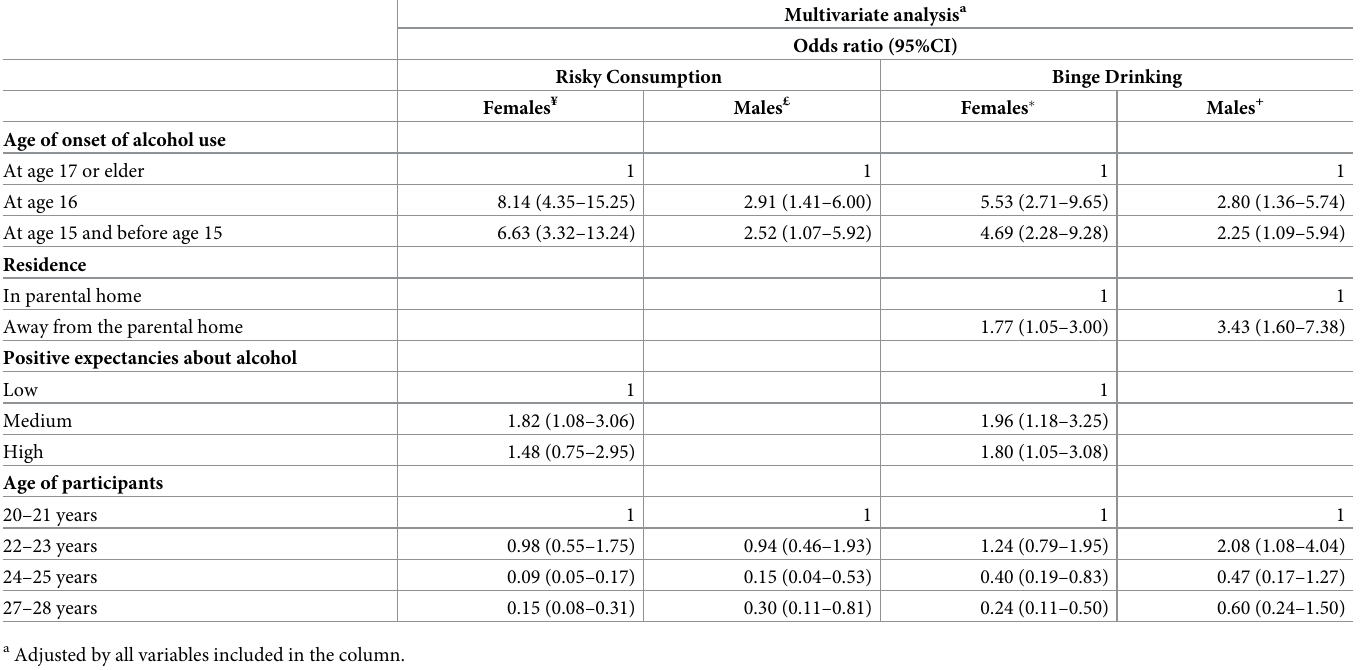
Table 5. Influence of different variables on risky consumption and binge drinking in subjects who did not partake in either of these consumption patterns at age 18–19